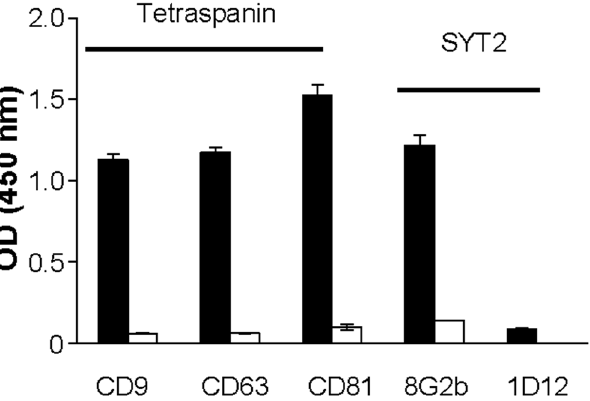
Figure 2. Characterization of SYT2-expressing exosomes. ExoSYT2 were captured on ELISA plates coated with anti-SYT2 (black bars) or anti-GST negative control antibodies (open bars). The presence of exosomal markers of the tetraspanin family (CD9, CD63 and CD81) was assessed using the corresponding antibodies. The orientation of SYT2 on captured exosomes (using mAb8G2b and mAb1D12 recognizing respectively the N-terminal and the cytosolic domains of SYT2) was verified. Error bars are SD from triplicates. Representative of 3 independent